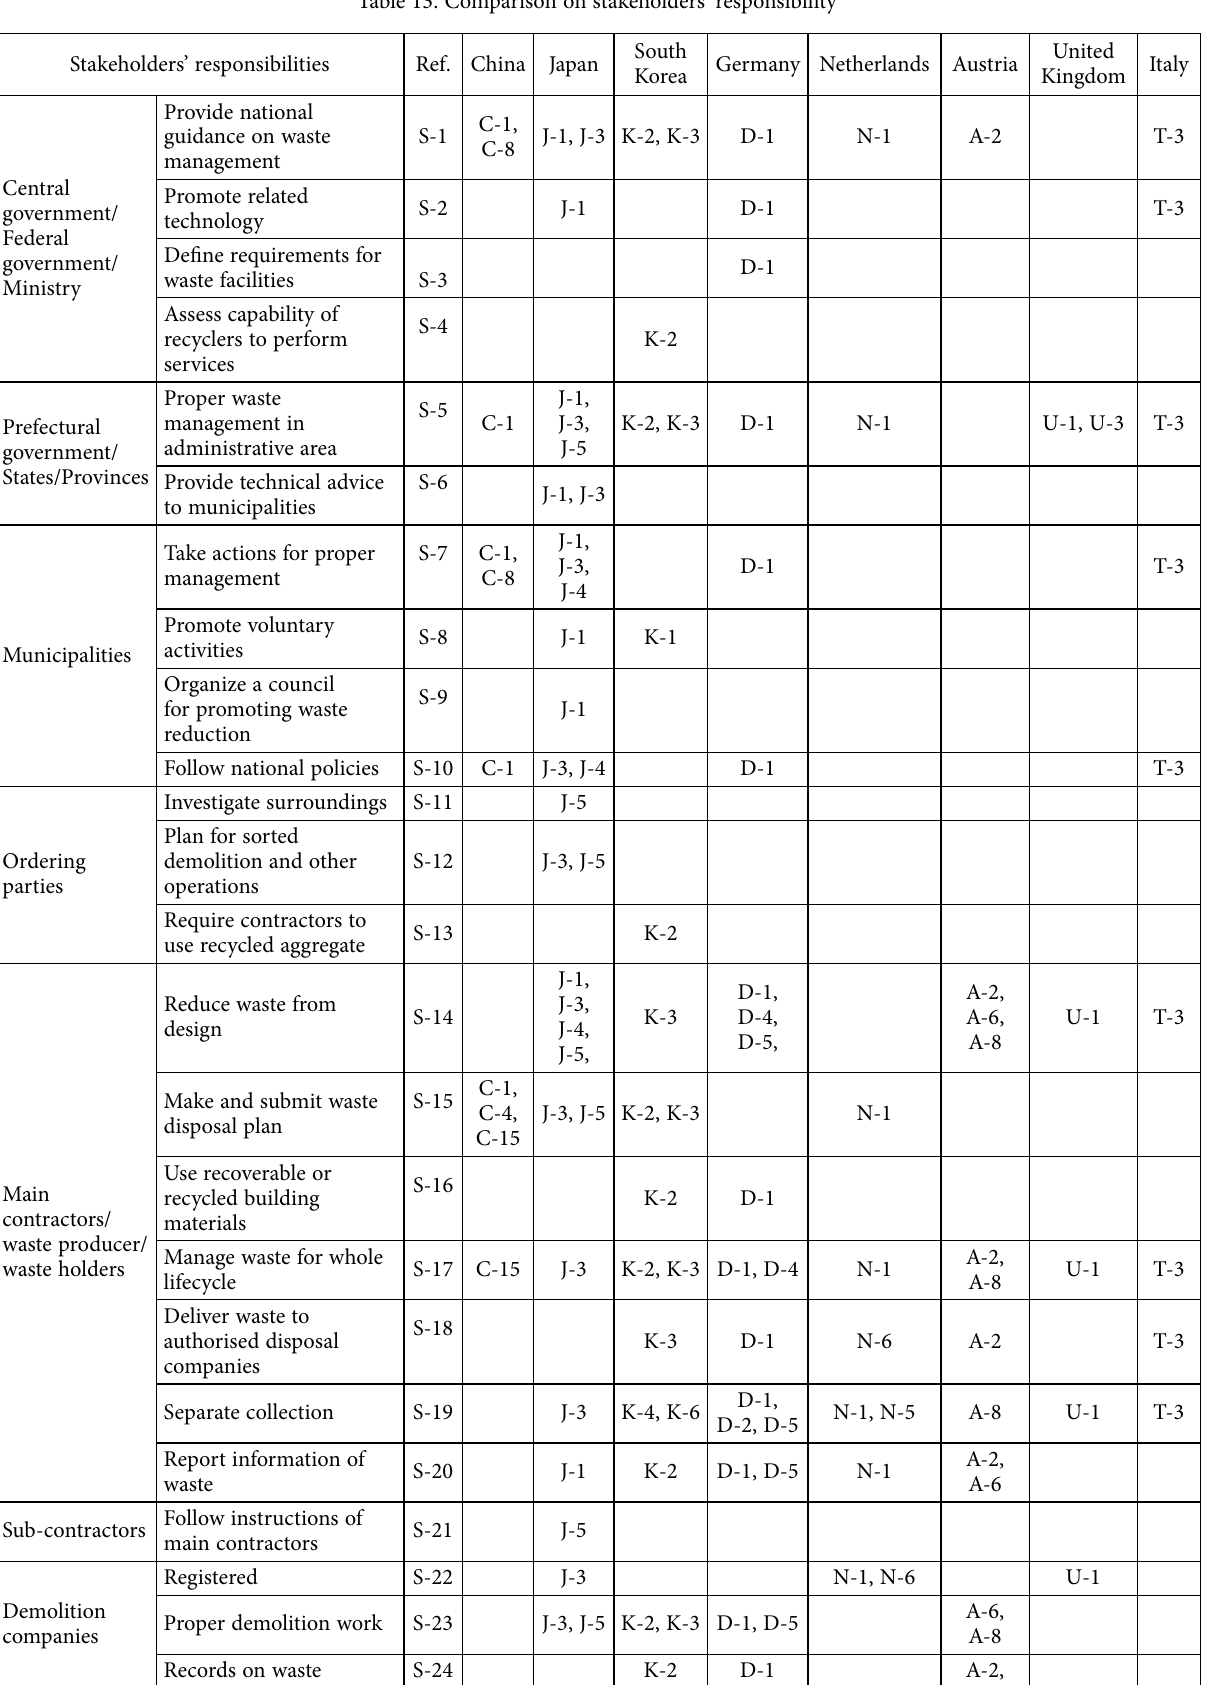
Table 13. Comparison on stakeholders’